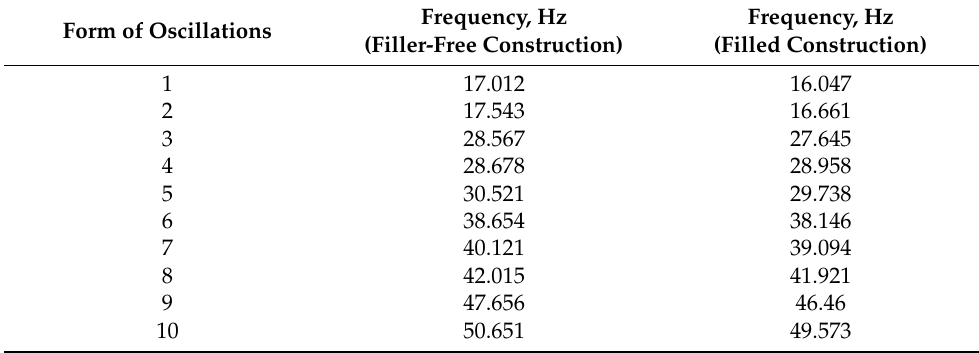
Table 1. Natural oscillation frequencies in the bearing structure of an open